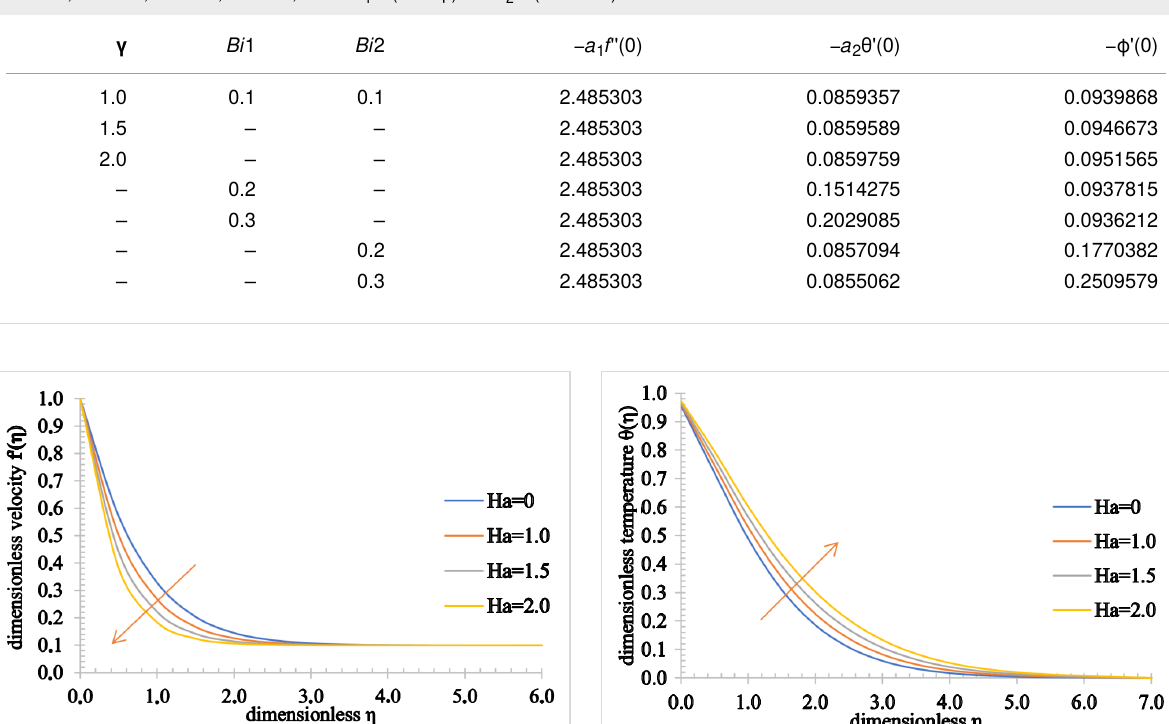
Table 5: The computed results of the skin-friction coefficient, Nusselt and Sherwood numbers for β = 0.5, Ha = 1, A = 0.1, R = 0.1, Pr = 0.7, Q = 0.1, Nt = 0.1, Nb = 0.5, Ec = 0.1, Sc = 1.2, where a 1 = (1 + 1/ β ) and a 2 = (1 + 4/3· R ).